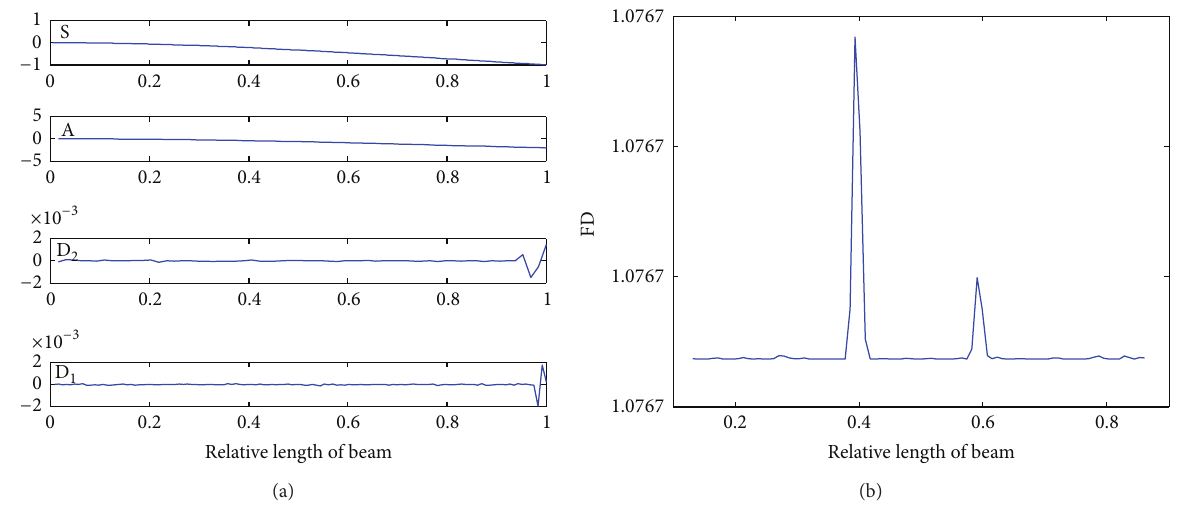
Figure 6: Crack location identification results in 100 dB noise level for the first mode shape. (a) Noise contaminated the first mode shape S N and its wavelet decomposition at level 2. (b) FD of the detailed signal D 1